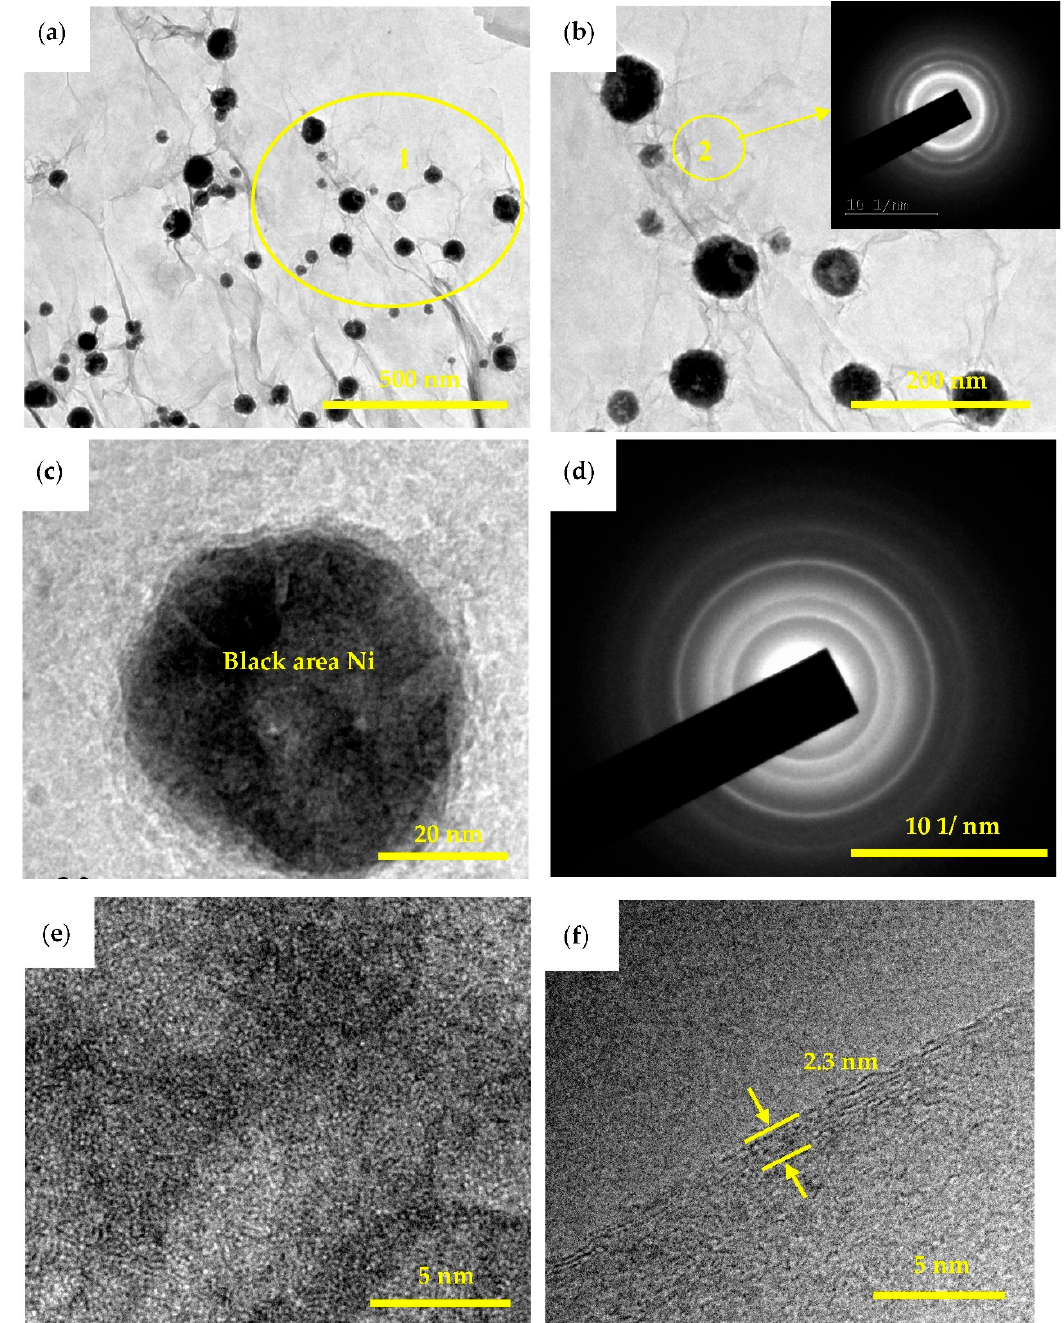
Figure 11. TEM images of Ni@graphene ( a ) and ( b ) TEM picture of Ni@graphene after reduced by sodium ascorbate; Insets are the corresponding SAED patterns; ( c ) single Ni particle on graphene; ( d ) the electron diffraction pattern of ( c ); ( e ) high resolution transmission electron microscope of Ni particle on graphene; ( f ) high resolution transmission electron microscope of graphene.